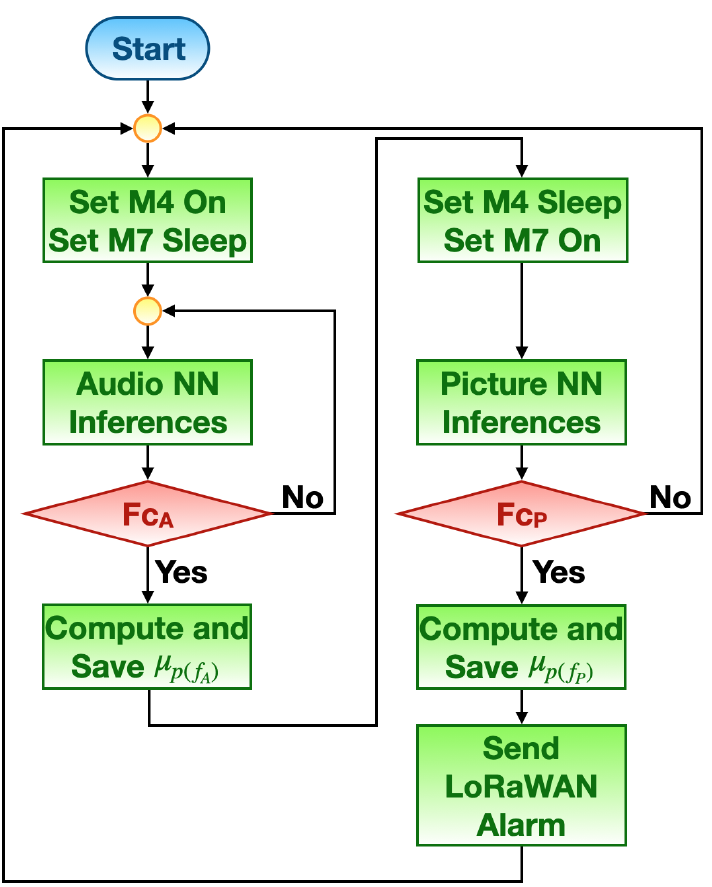
Figure 3. VSU prototype functioning flow